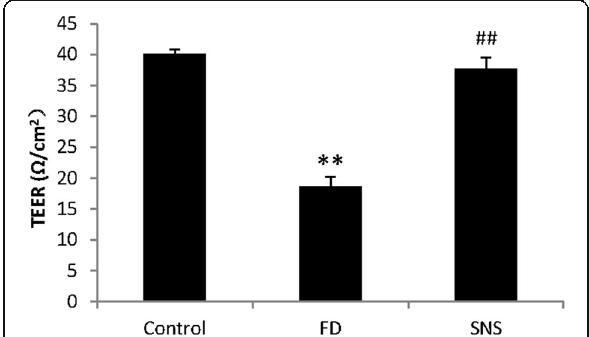
Fig. 2 Duodenal TEER. The model group had a prominently decreased TEER compared with the control group, and SNS treatment remarkably enhanced the TEER level of FD rats. All data were represented as mean ± SEM (6 rats in each group). ** P < 0.01 compared with the control group; ## P < 0.01 compared with